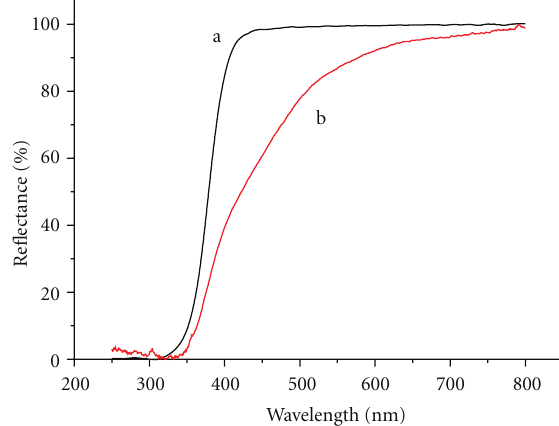
Figure 6: UV-vis spectra of the initial sample TIT 144 (a) and the sample TIT 144 ground ammonium carbamate addition